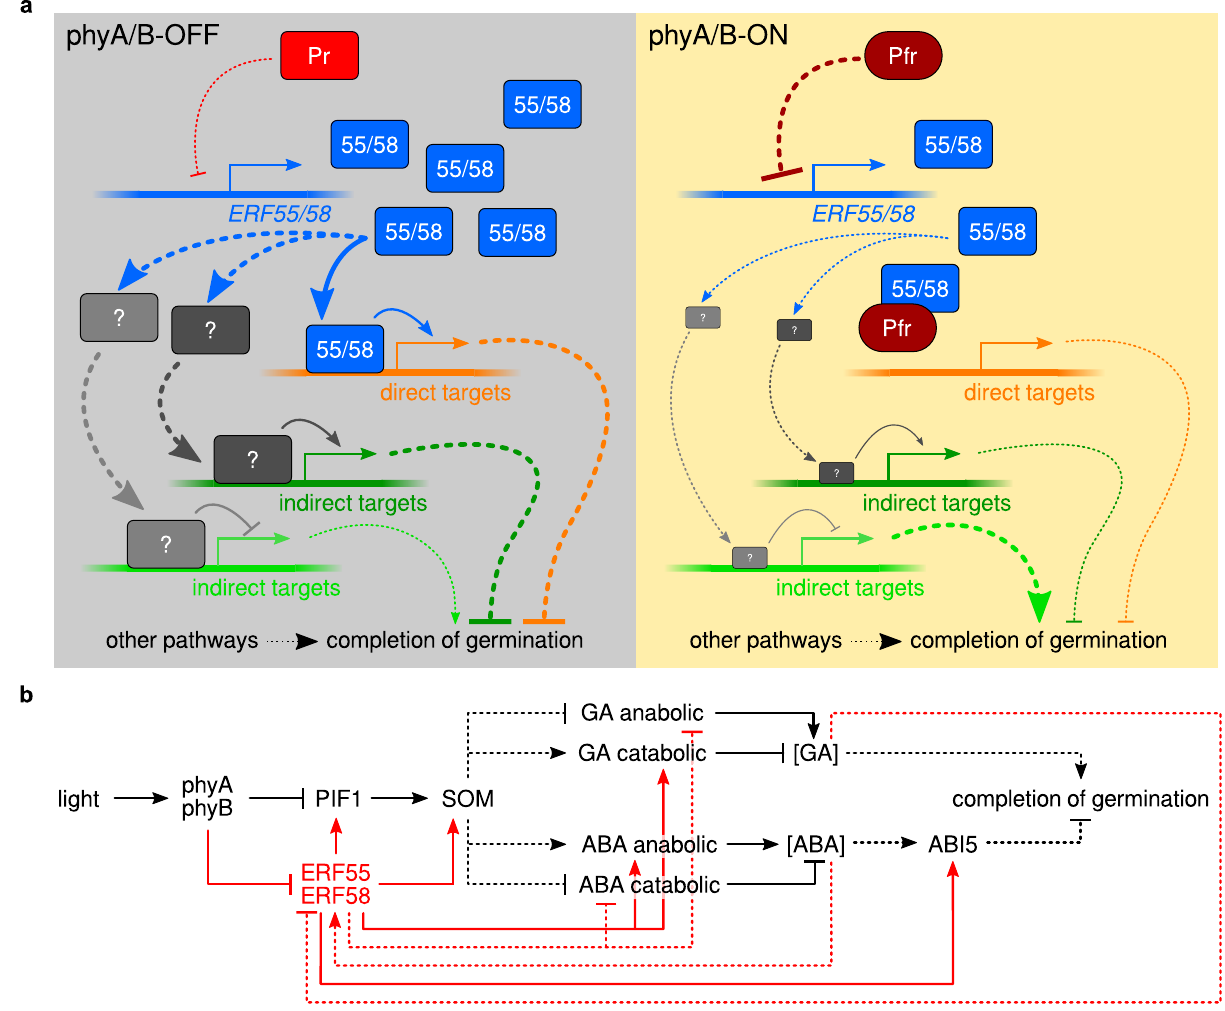
Fig. 9 Light regulation of the completion of seed germination by ERF55 and ERF58. a Model for regulation of the completion of seed germination by ERF55/ERF58 and phytochromes. In phyA/B-OFF conditions (e.g. in the dark), ERF55 and ERF58 bind to the promoter of genes that repress the completion of seed germination and enhance their expression (direct targets; shown in orange). Genes that promote the completion of seed germination can be repressed by ERF55/ERF58 through upregulation of intermediate factors (shown in grey) but they are possibly not direct targets of ERF55/ERF58. Indirect targets of ERF55/ERF58 are shown in green and may either promote (light green) or repress (dark green) completion of germination. Light-activated phytochromes repress the expression of ERF55 and ERF58 in phyA/B-ON conditions and also bind ERF55 and ERF58 to prevent their association with the promoter of various target genes that repress the completion of germination. Solid lines indicate direct regulation; dashed lines indicate indirect regulation; → , positive regulation; ⊣ , negative regulation; thick arrows, strong regulation; thin arrows, week or no regulation. b Simpli fi ed regulatory network for light regulation of the completion of seed germination. Regulatory interactions of ERF55/ERF58 are shown in red; other regulatory interactions are shown in black. Solid lines indicate direct regulation; dashed lines indicate indirect regulation or regulatory steps for which it is not known whether they are direct or indirect; → , positive regulation; ⊣ , negative